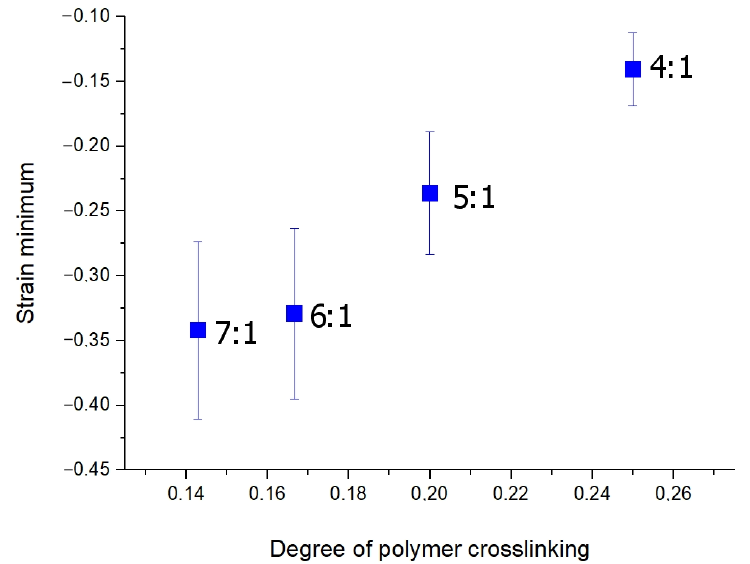
Figure 5. The osmotic ‐ induced strain minima observed with OCE plotted as a function of the crosslinking degree of the polyacrylamide gels.